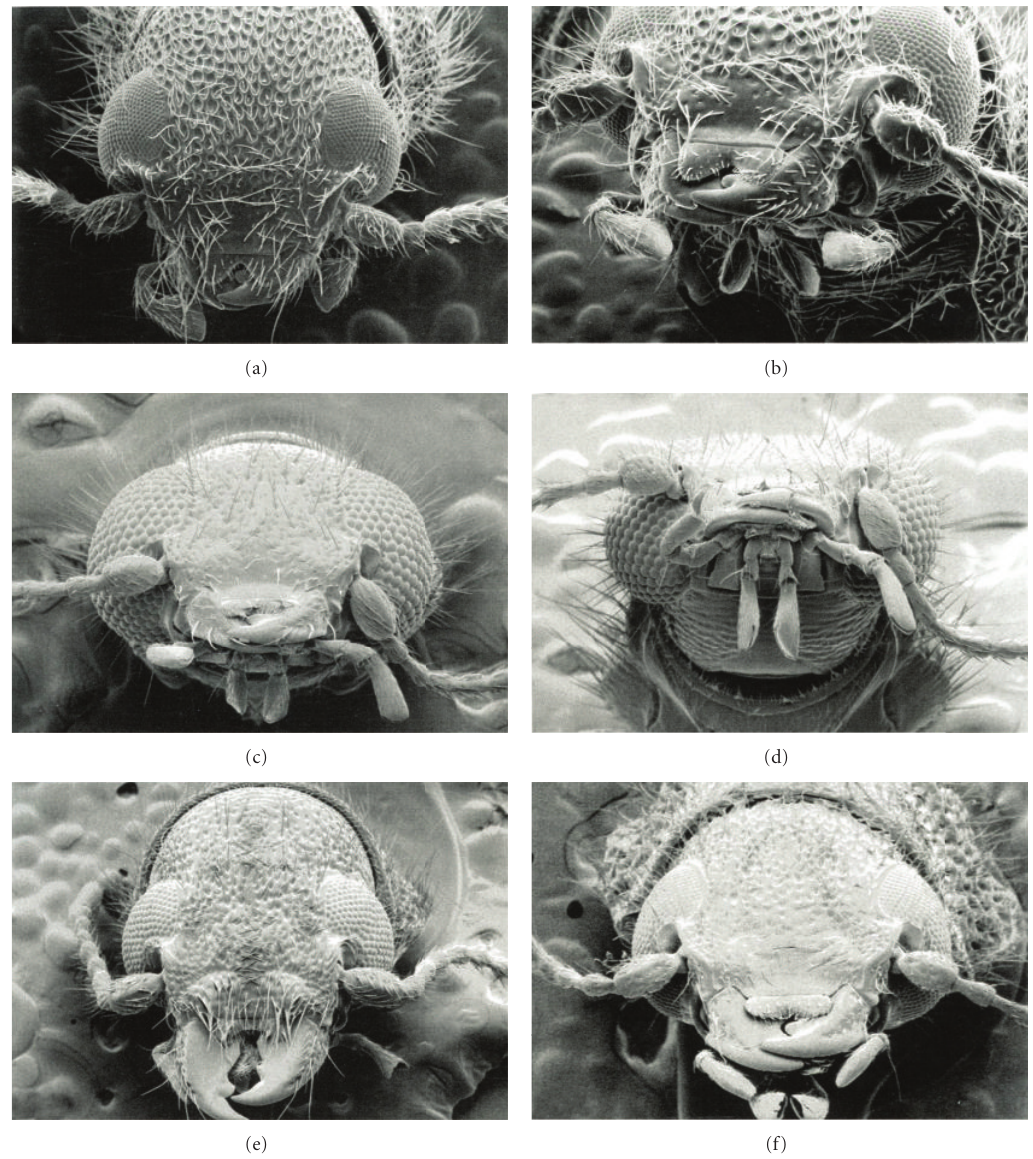
Figure 12: Various organs. (a, b) Blackburniella intricata ((a) head, (b) mouthparts). (c, d) Fallopylus pallipes ((c) head, (d) mouthparts). (e) Neopylus nahuelbutensis head. (f) Parapylus bicinctus head.